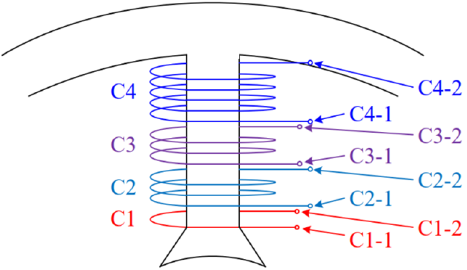
Figure 8. Experimental setup for ITSCs detection.